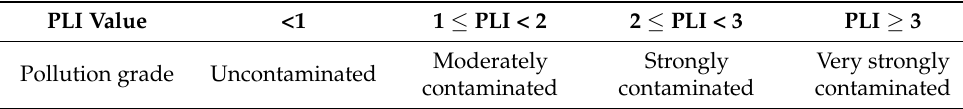
Table 1. Category of the pollution load index (PLI).